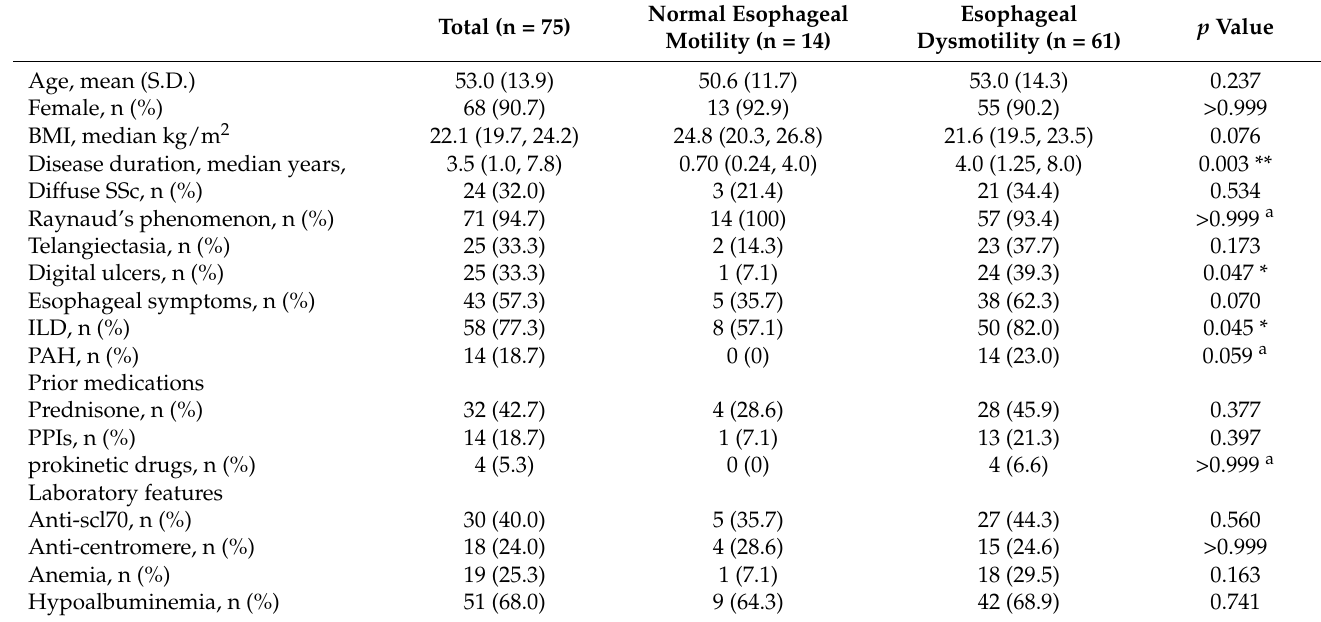
Table 1. Demographic and clinical characteristics of SSc patients with and without esophageal dysmotility.